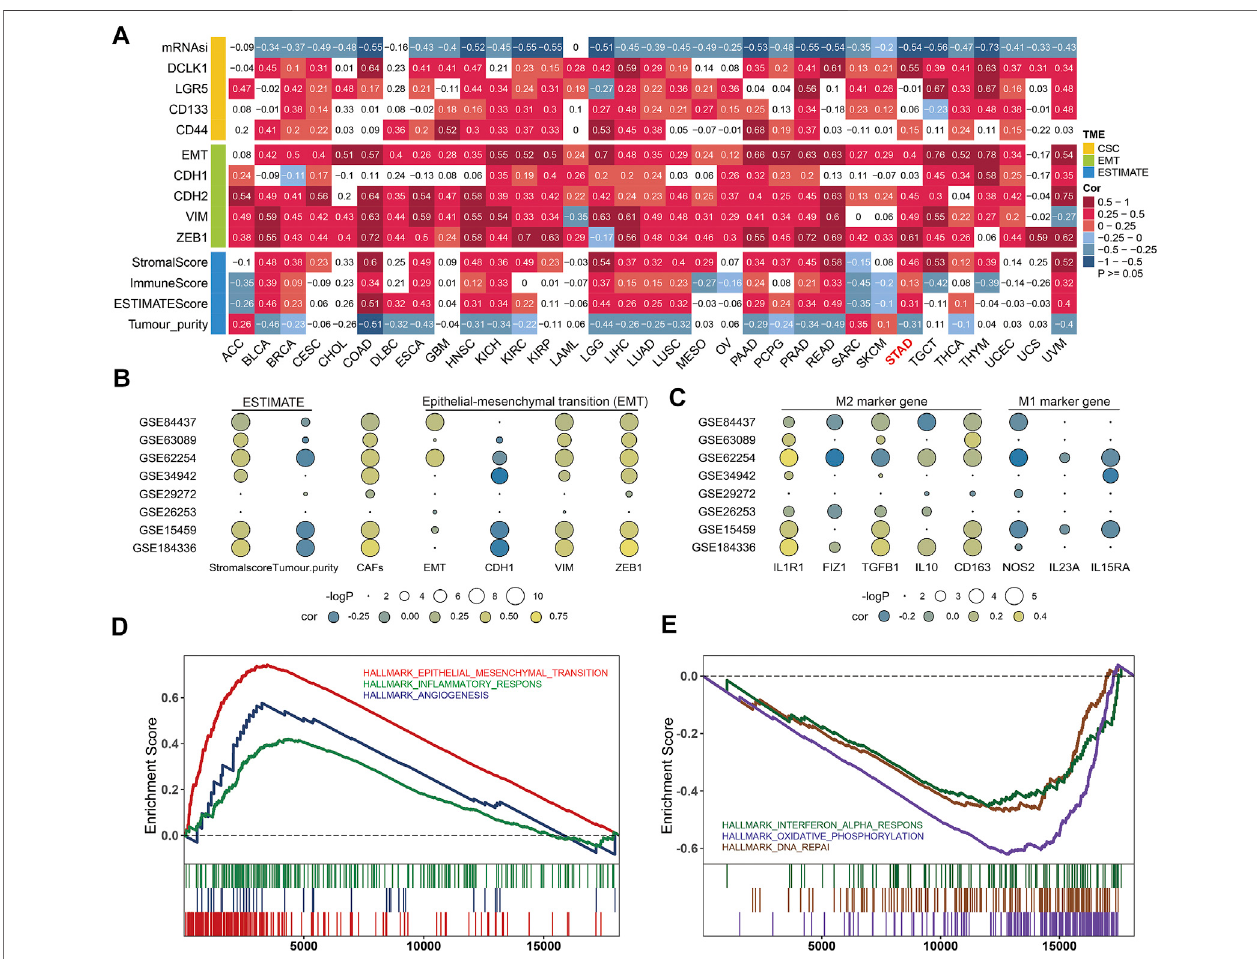
FIGURE 5 | TGF β 2 and gastric cancer microenvironment. (A) Correlation analysis of TGF β 2 with CSC, EMT and ESTIMATE in The Cancer Genome Atlas (TCGA). (B) Bubble plots ofthe correlation between TGF β 2 and ESTIMATE (Stromalscore and Tumor purity), CAFs and EMT (EMT, CDH1, VIM, ZEB1) inmultiple GEO datasets. (C) Bubble plots of TGF β 2 correlation with M1 (IL1R1, FIZ1, TGF β 1, IL10 and CD163) and M2 (NOS2, IL23A and IL15RA) marker genes in multiple GEO datasets. Different colors represent different correlations. (D,E) Gene Set Enrichment Analysis (GSEA) was used to analyze the differences in gene function among different TGF β 2